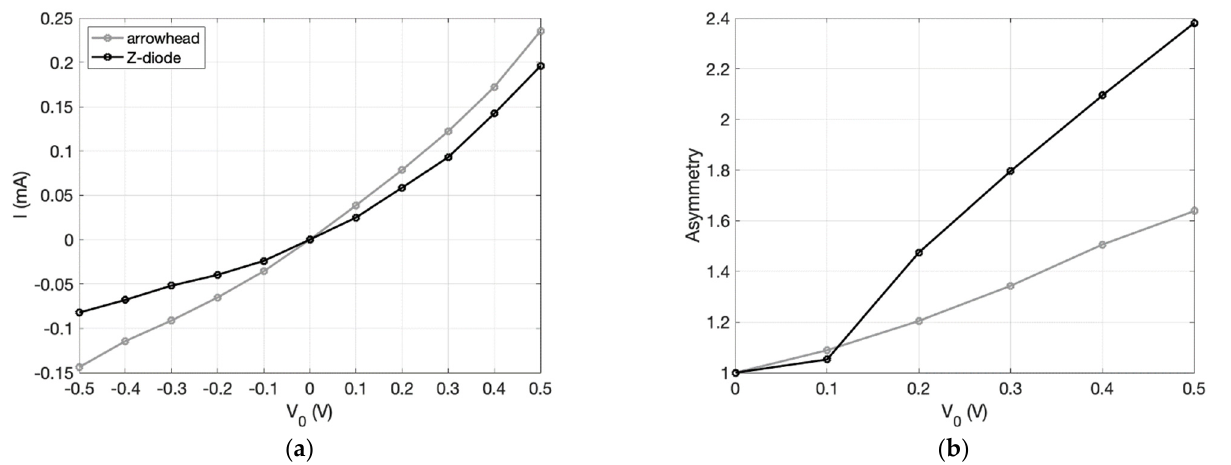
Figure 5. Comparison of inverse-arrowhead diode and Z-diode. ( a ) The current–voltage characteristics of both geometries and ( b ) the resulting current asymmetries. Both diodes have λ MFP = 500 nm, d n = 100 nm, and d s = 1 µ m. It is unclear why the asymmetry is slightly higher for the inverse arrowhead diode at 0.1 V. It is possible that it is an artifact of the simulator at low